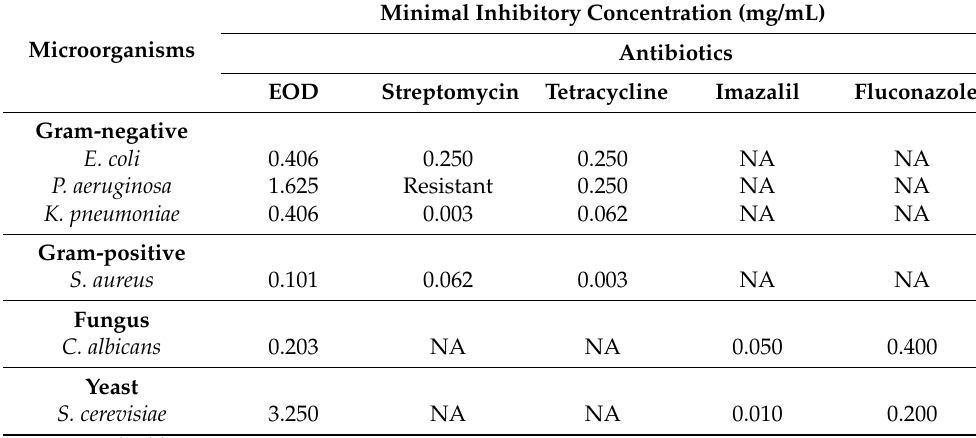
Table 5. Minimum inhibitory concentrations (MIC) (mg/mL) of the EO extracted from D. viscosa . The comparison was performed with synthetic